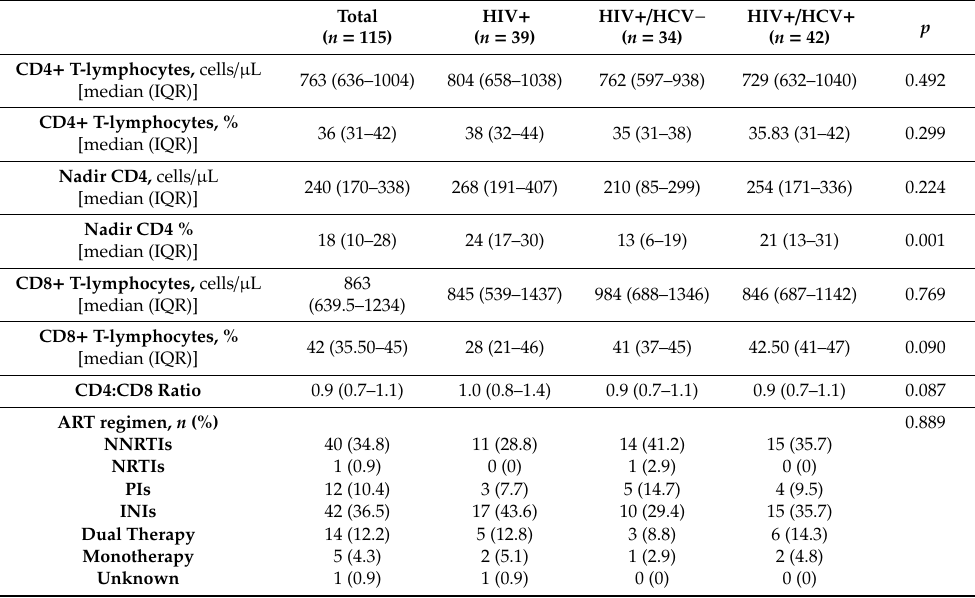
Table 2. Clinical and immunological characteristics of study